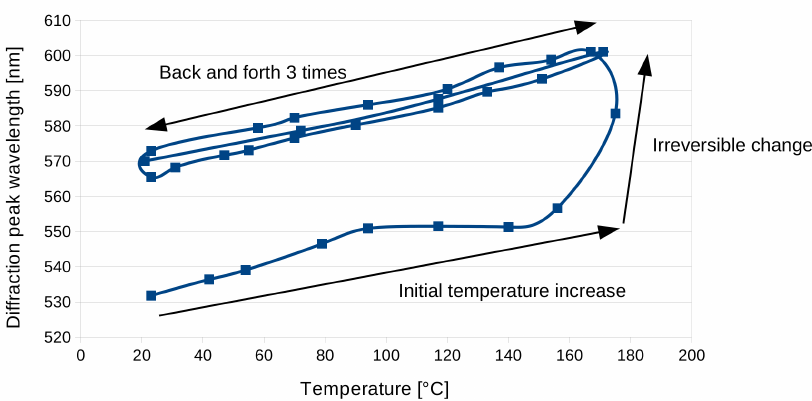
Figure 8. Wavelength minimum of the transmission spectra of the Bayfol ® HX200 reflection hologram depending on temperature for two temperature cycles.